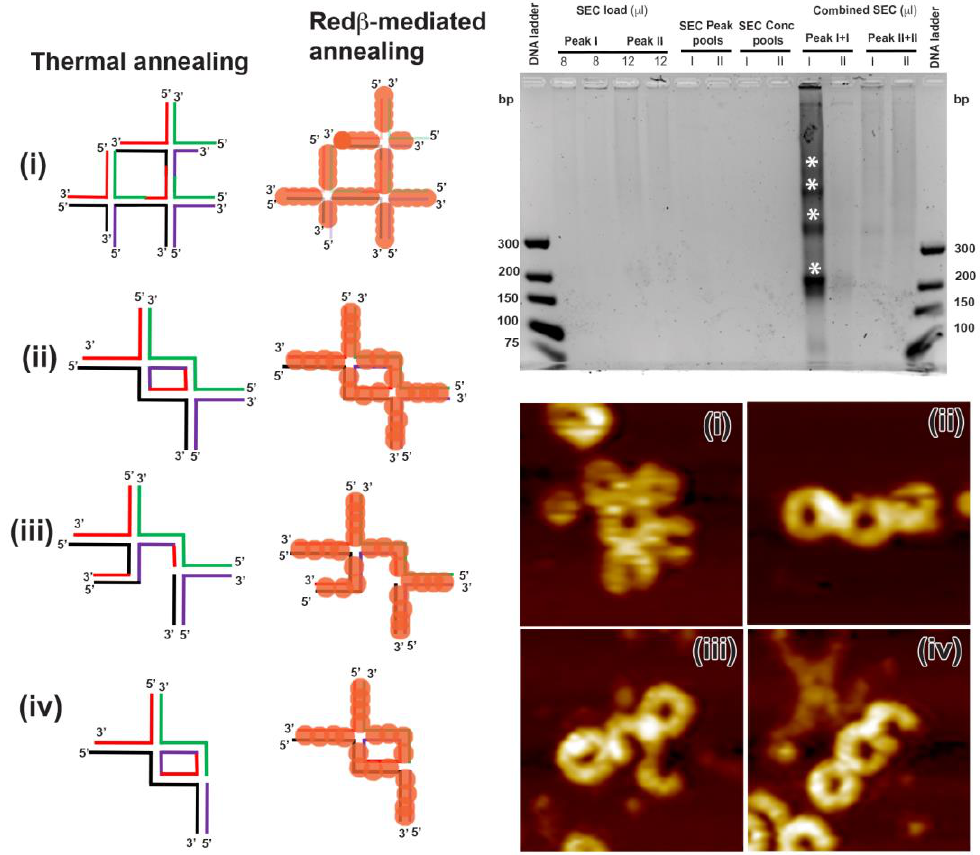
Figure 7. The schematic structures show possible hierarchical assemblies composed of S1S4 and S5S8 HJ junction structures assembled by thermal and Red β -mediated annealing. The corresponding sodium borate agarose gel analysis was conducted with the input and the pooled fractions after SEC, as explained in Figure 5. The asterisks indicate the hierarchical HJ assemblies. The AFM images of Peak I (see Figure 5) were recorded after SEC purification and show hierarchical HJ assemblies corresponding to the schematic structures ( i – iv ). The AFM images have a size of 125 × 125 nm² and a height scale of 4 nm.